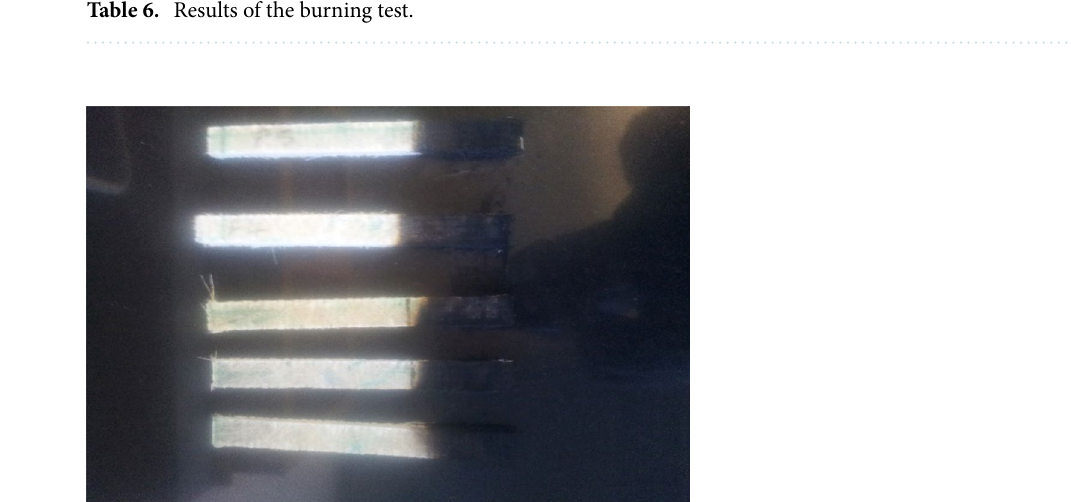
Table 6. Results of the burning test.